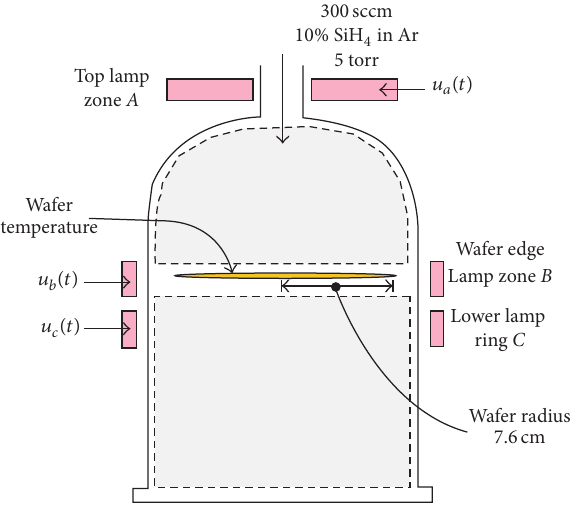
Figure 2: Structure of a RTCVD system.